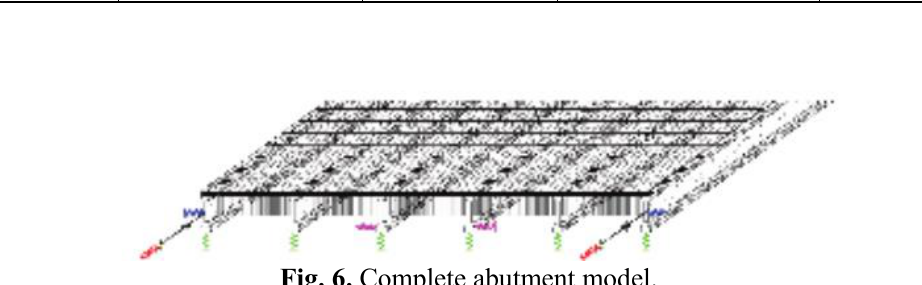
Fig. 6. Complete abutment